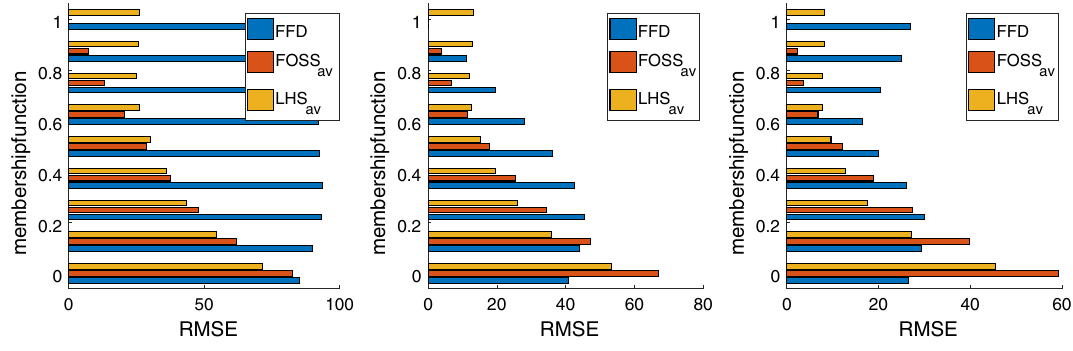
Fig. 16 Branin function: average RMSE on 𝛼 -cuts for a DACE surrogate with 4 (left), 9 (center), and 16 (right) sampling points